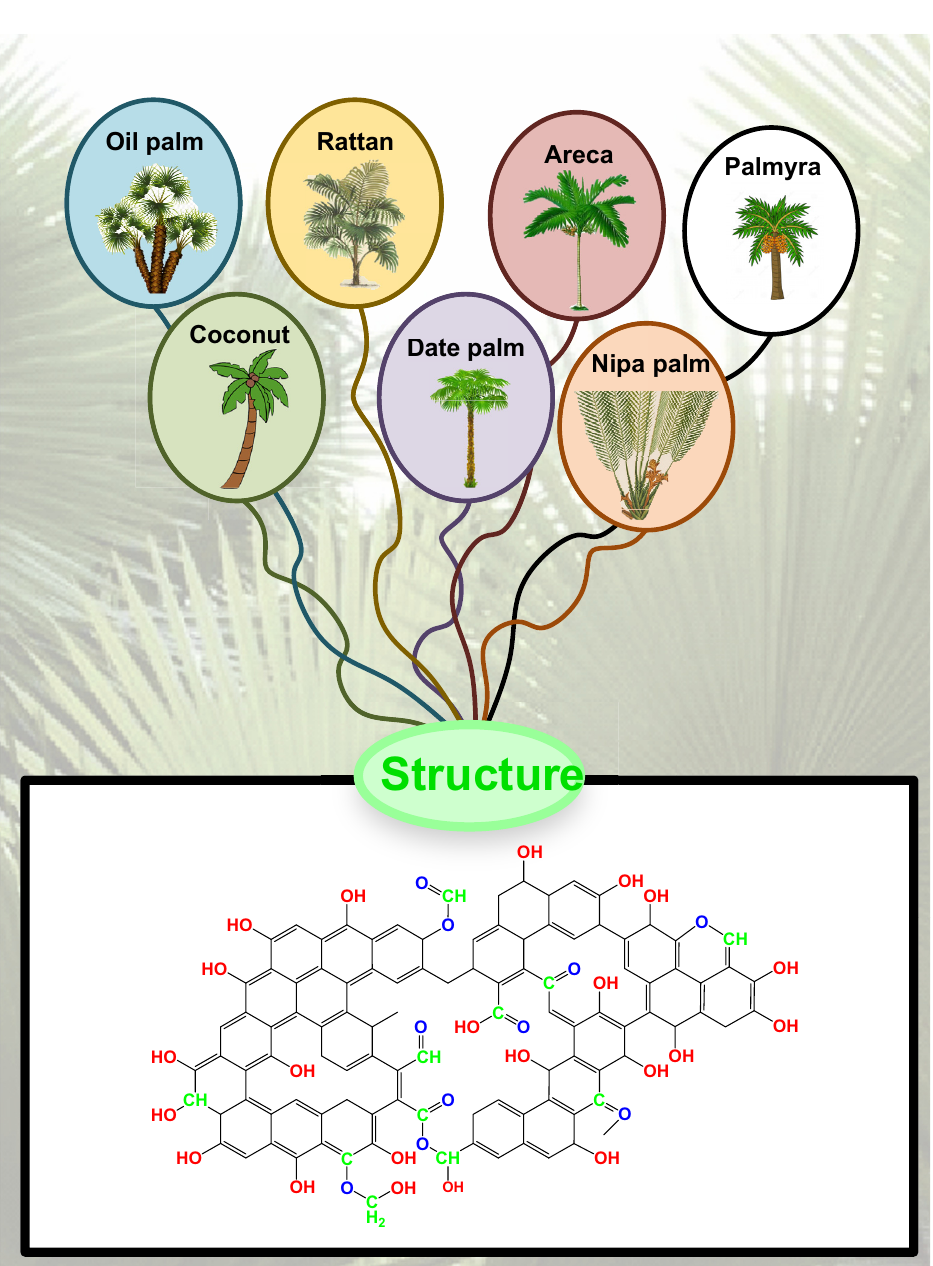
Figure 3: AC structure from